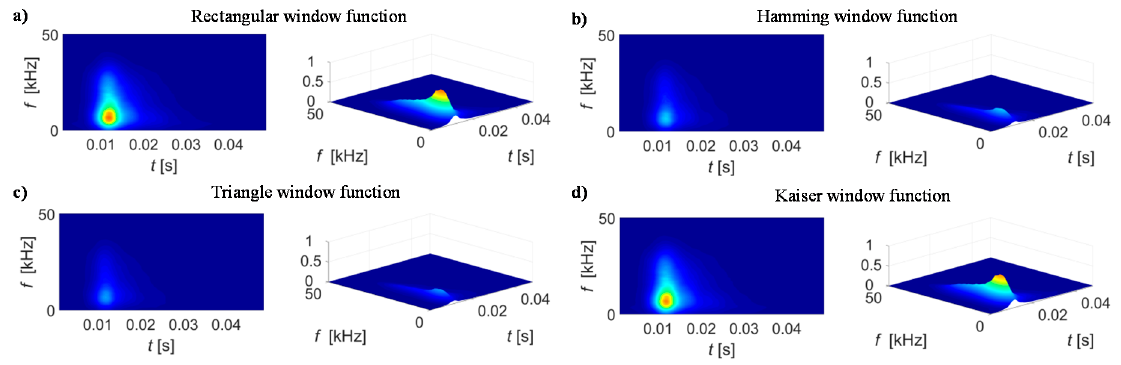
Figure 5. Spectrogram results obtained using window of 512 samples defined by function: ( a ) rectangular, ( b ) Hamming, ( c ) triangular, ( d ) Kaiser. The excitation and sampling frequency were equal respectively 10 Hz and 500kHz.